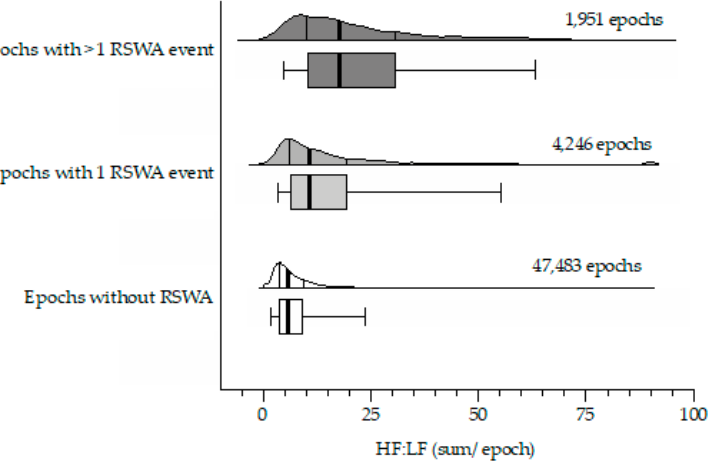
Figure 3. Epoch-based HF:LF analysis: horizontal violin plots (non-truncated/halved) with corre- sponding box-whisker plots illustrating the spread across Group E1 (open plot; average HF:LF in all epochs of REM sleep without REM sleep without atonia), Group E2 (light shaded plot; average HF:LF in every epoch of REM sleep with exactly 1 REM sleep without atonia event), and Group E3 (heavy shaded plot; average HF:LF in every epoch of REM sleep with ≥ 2 REM sleep without atonia events). The heavy solid line corresponds to the median value with the 25th and 75th percentile indicated by the bracketed lines/box outline. Whiskers indicate the 5th and 95th percentiles.